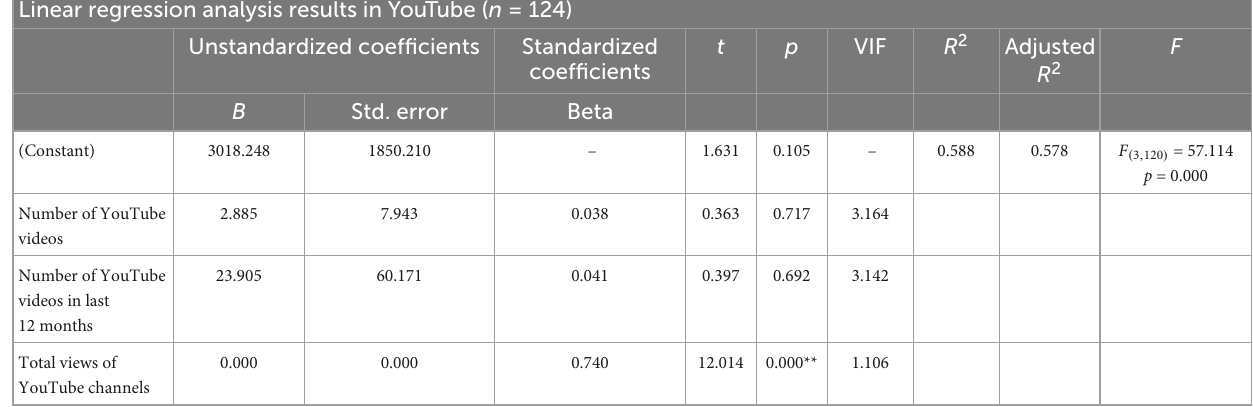
TABLE 5 Linear regression analysis of the effect of the number of YouTube videos in the last 12 months, number of YouTube videos, and total views of YouTube channels on the number of YouTube subscribers. Linear regression analysis results in YouTube ( n =